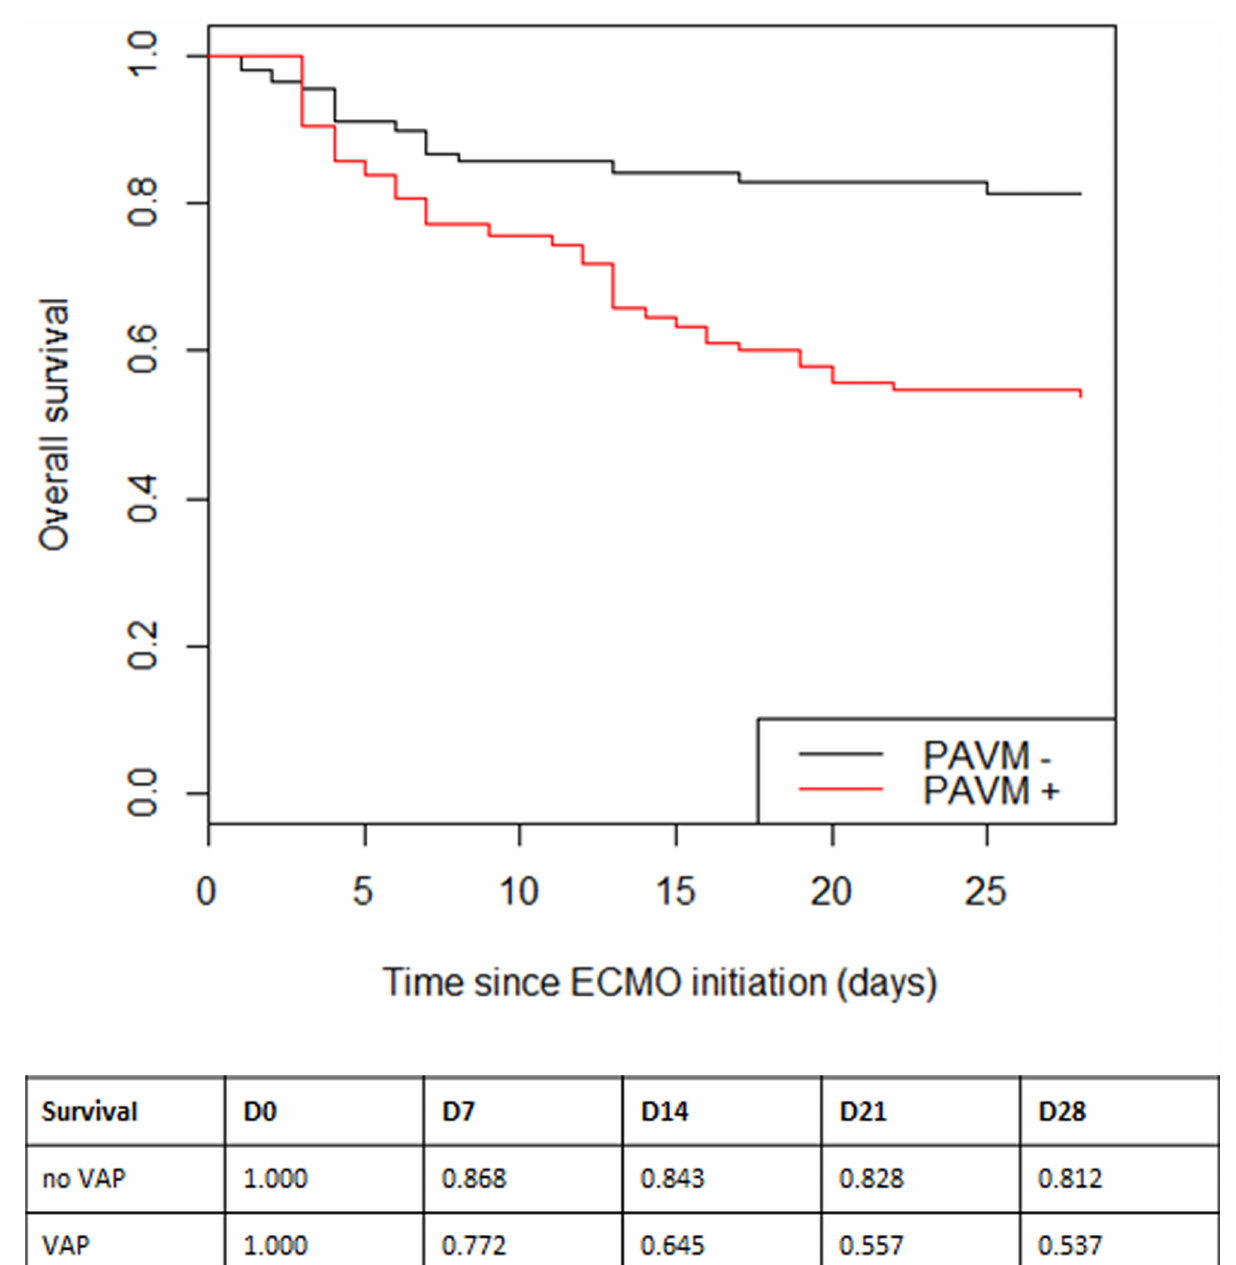
Fig 1. Kaplan-Meier analysis of the probability of survival according to the presence of a VAP during ECMO support. The 28-day survival was significantly lower in the VAP group (red line) in comparison to the no VAP group (black line) (nominal p < 0.001).